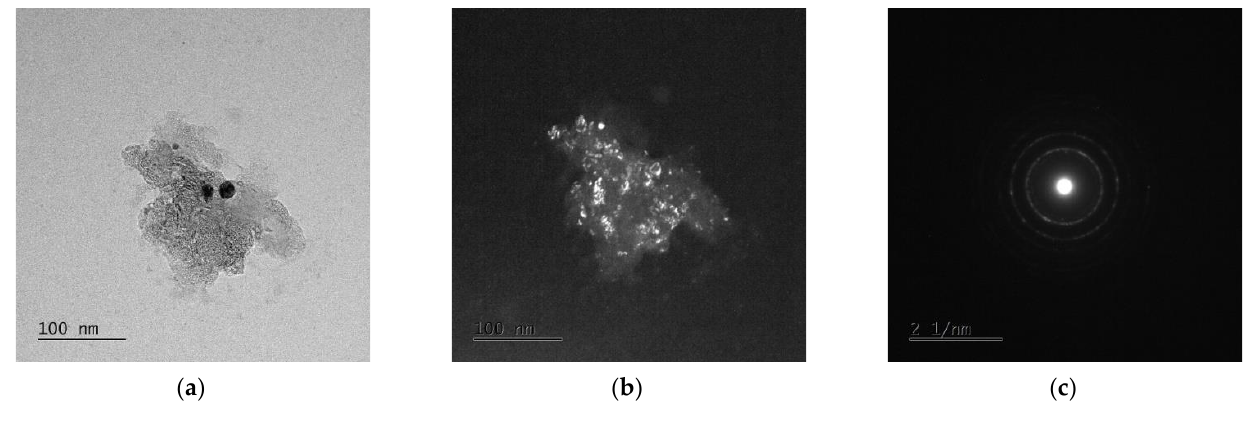
Figure 6. TEM images of Mg 65 Zn 30 Ca 4 Ag 1 alloy milled for 50 h. ( a ) Bright field image, ( b ) dark field image, ( c ) SAED pattern from tested region.